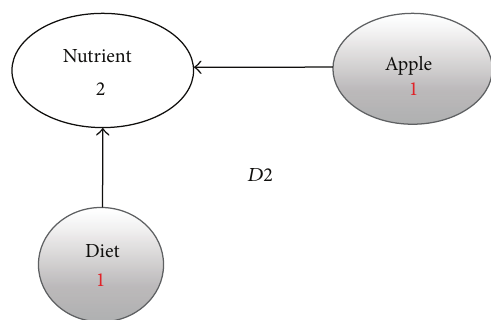
Figure 16: Frequencies after spreading activation for 𝐷2 .